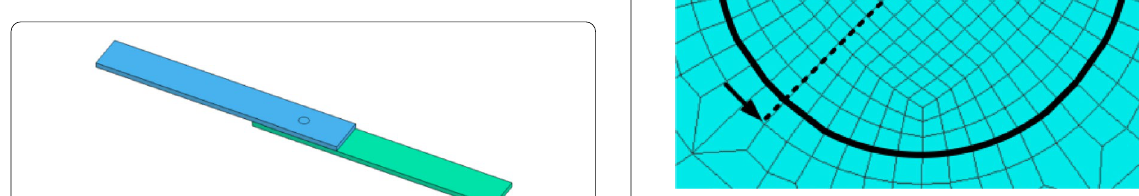
Figure 4 Schematic diagram of the observation direction of the metallographic